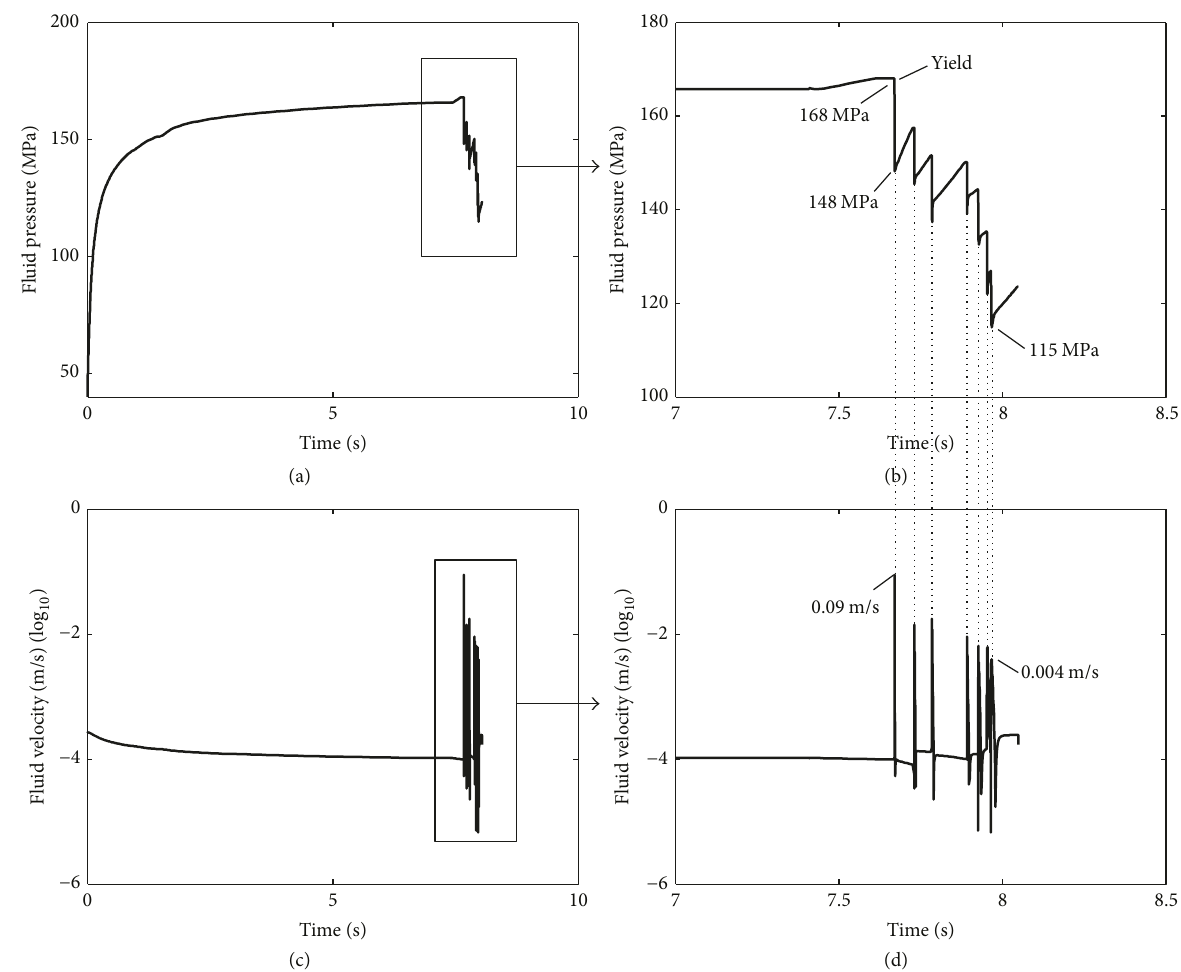
Figure 5: The fluid flow at the reference point in the numerical experiments: ((a), (b)) fluid pressure; ((c), (d)) fluid velocity.